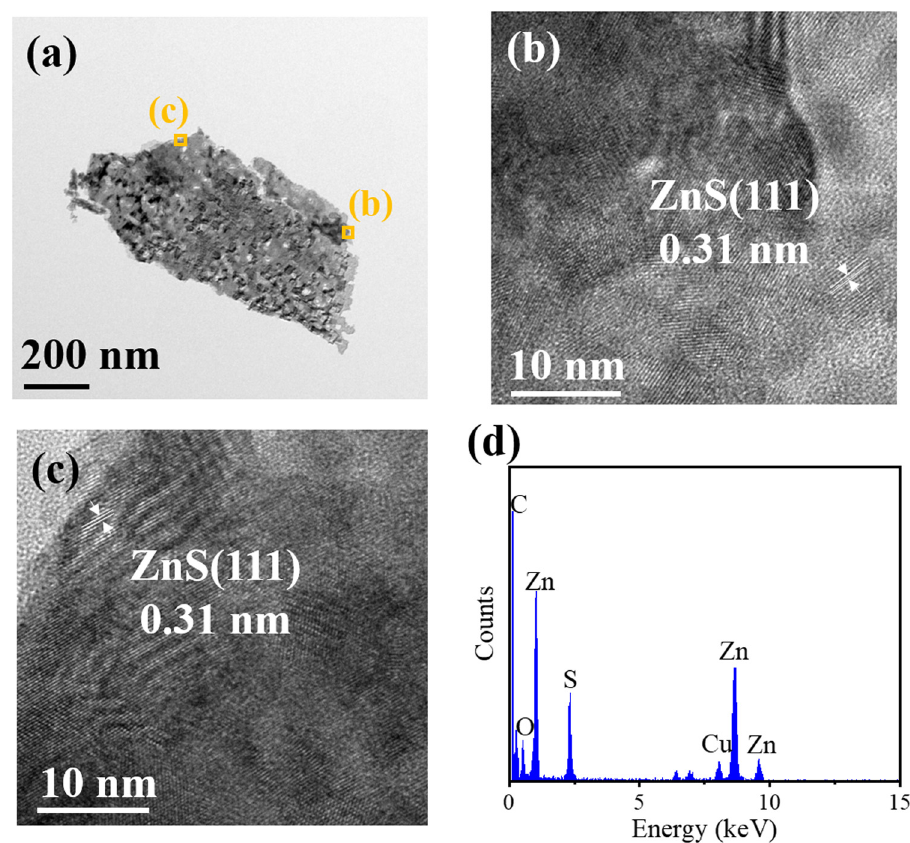
Figure 4: TEM analysis of the ZS - 2: ( a ) low - magni fi cation image. ( b ) and ( c ) HRTEM images of various local regions in image ( a ) . ( d ) EDS